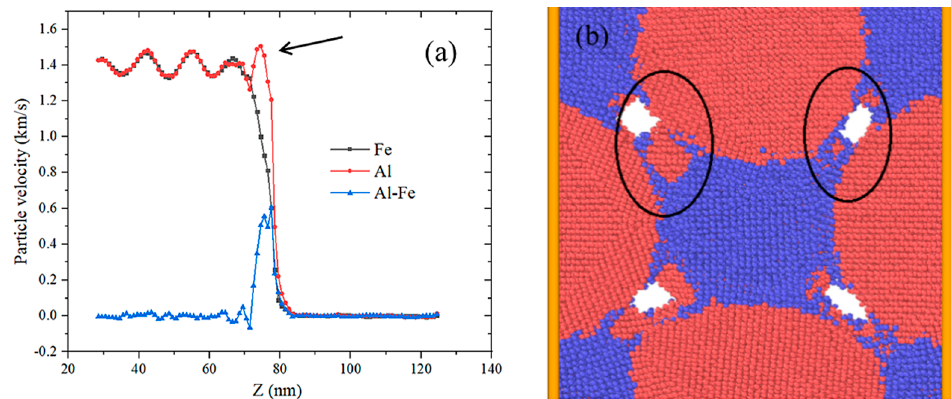
Figure 14. Velocity difference of Al and Fe particles: ( a ) comparison of the velocity of Al and Fe particles; ( b ) an enlarged view of the particle morphology at the arrow shown in ( a ).